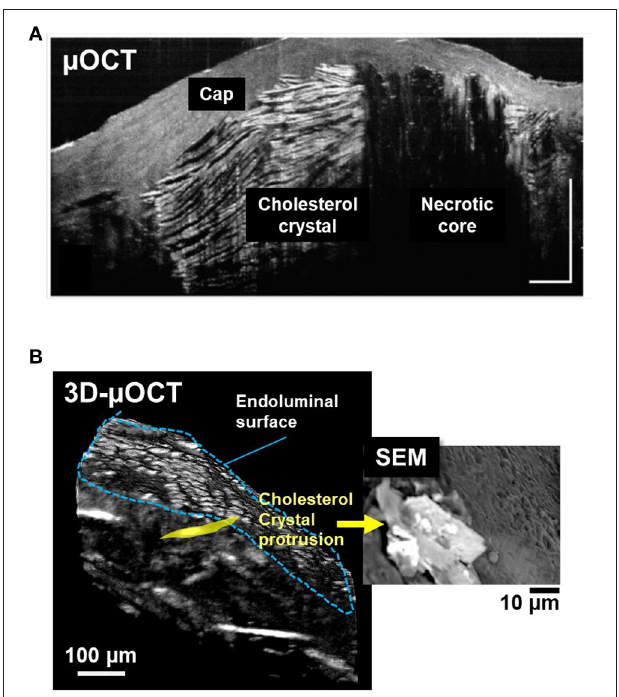
FIGURE 5 | 3D- µ OCT for visualizing cholesterol crystals and their protrusion in the human cadaver coronary artery ex vivo. (A) Fibroatheroma with large necrotic core (NC) showing multilayered cholesterol crystals (CC), characterized by reflections from their top and bottom surfaces. Scale bars, 30 µ m. Figure and capture reprinted with permission from Liu et al. (28). (B) 3D- µ OCT for a fibroatheromatous human coronary plaque with manually segmenting a protruding cholesterol crystal (yellow area). (B) Corresponding SEM image showing cholesterol crystals protruding from the arterial wall. Unpublished data, obtained at the Massachusetts General Hospital.